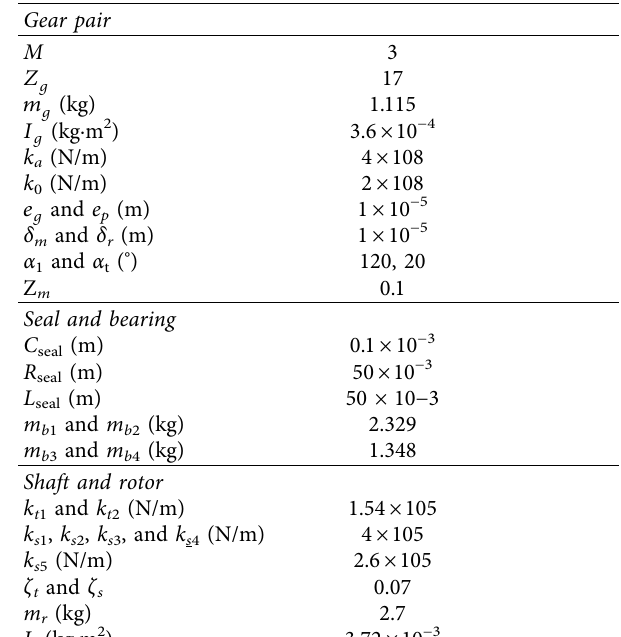
Table 1: Main parameters of the GRSB